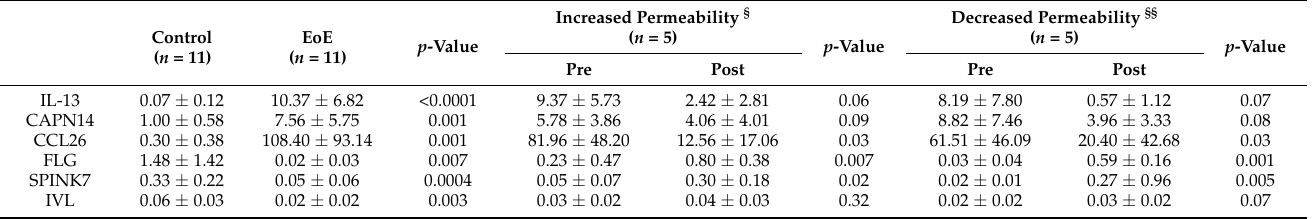
Figure 2. Infiltration of mast cells and IgG4 deposits in controls and EoE patients before and after treatment. ( a – d ) CD117 staining of esophageal biopsy sections. ( e – g ) Mast cell counts in: controls (cont, n = 11) and EoE ( n = 11, ( e )), EoE before treatment (pre, n = 5) and after treatment (post, n = 5) among patients with unchanged permeability ( f ), and EoE before treatment (pre, n = 5) and after treat- ment (post, n = 5) among patients with decreased permeability ( g ). ( h – k ) IgG4 immunofluorescence (red) and nuclear staining with DAPI (blue) in biopsy sections. Representative immunohistochemical and immunofluorescence staining of controls ( a , h ), EoE patients before treatment ( b , i ), EoE patients after treatment with unchanged permeability ( c , j ), and EoE patients after treatment with decreased permeability ( d , k ). Data are expressed as mean ± standard deviation. DAPI, 4 (cid:48) ,6-diamidino-2- phenylindole; EoE, eosinophilic esophagitis; HPF, high-power field; Ig, immunoglobulin. * p < 0.05, **** p < 0.0001. Bar = 50 µ m. Table 2. Gene expression in biopsy samples from controls and EoE patients before and after